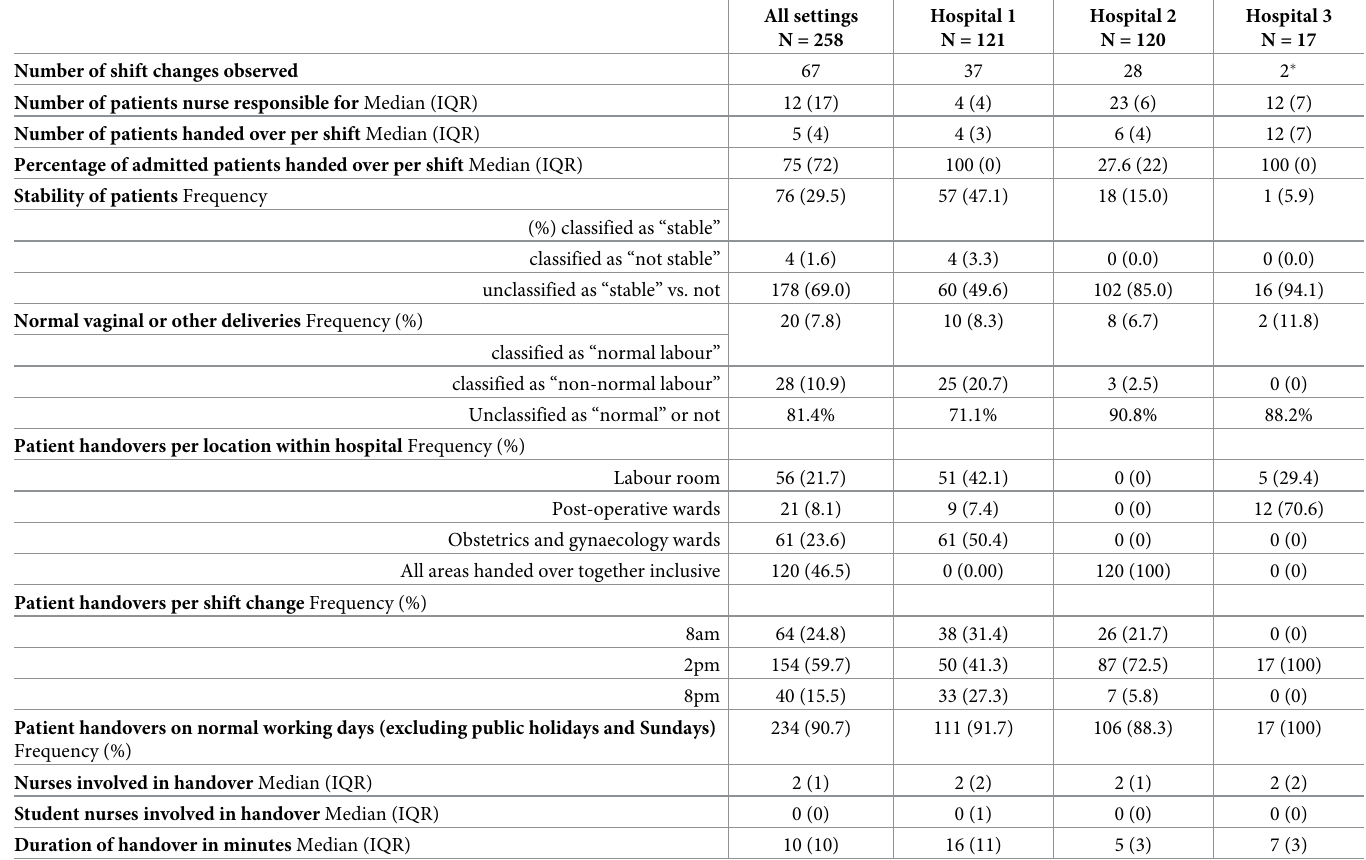
Table 1. Background characteristics of observed handover sessions and individual patient handovers.